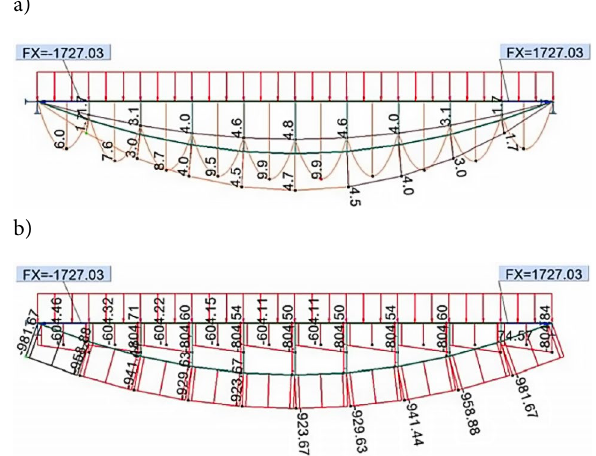
Figure 4. Diagrams from Autodesk Robot Structural analysis: